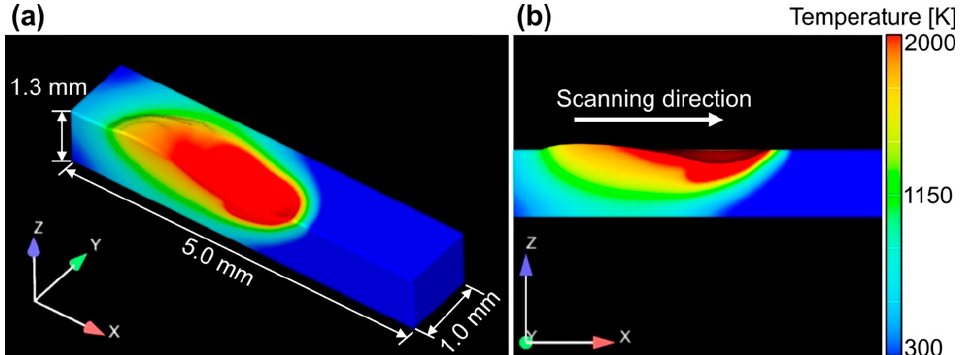
Figure 5. ( a ) Average grain size and ( b ) their aspect ratio evaluated from EBSD IPF orientation maps taken from the electron-beam irradiated regions in 316L and 304 SS samples.